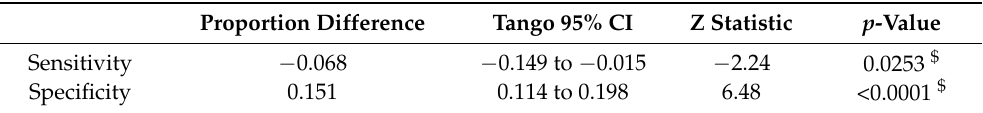
Table 4. Comparison of sensitivities and specificities of GeneXpert and LPA methods in detecting rifampicin